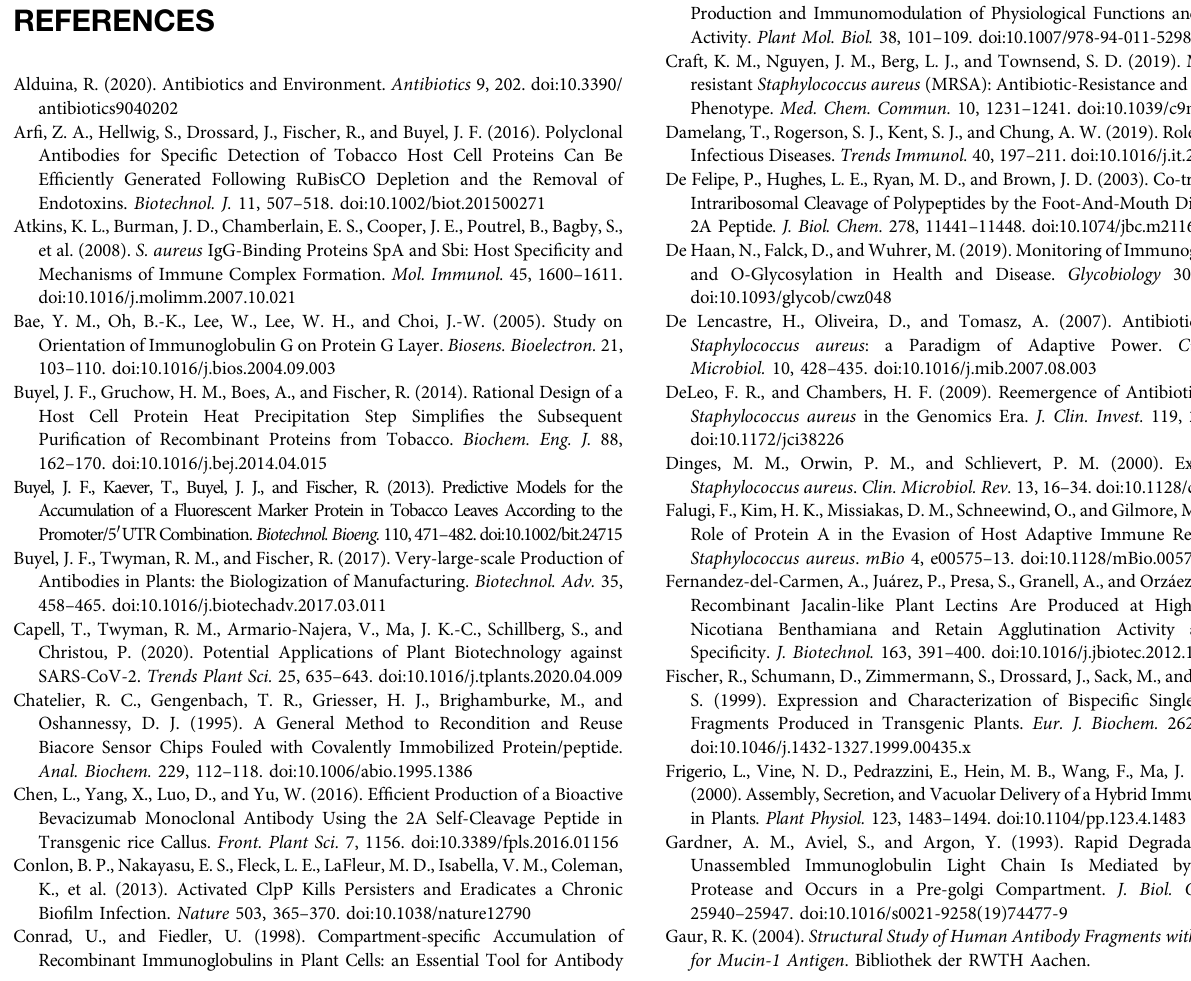
Supplementary Figure S3 | Accumulation and integrity of IgG1 and IgG3 variants in BY-2 PCPs. (A – D) Accumulation of IgG3 (A) , IgG3 variant with IgG1 CH3 domain (B) ,IgG3variant featuringIgG1CH2 andCH3domains (C) and IgG1 (D) dependent on the subcellular compartment and 5 ′ UTR. Even though silver-stained LDS gels Supplementary Figure S4 | Comparison of model predictions (80% or 95% con fi dence interval, CI) and veri fi cation runs for mAb accumulation and integrity. (A) SPR measurement of IgG accumulation dependent on subcellular compartment and IgG scaffold. (B) Antibody integrities evaluated by densitometric analysis of silver-stainedLDSgelsdependentonthesubcellularcompartmentandIgGscaffold. The broad con fi dence interval for IgG accumulation originated from substantial batch-to-batch variation during expression in PCPs. The data correspond to